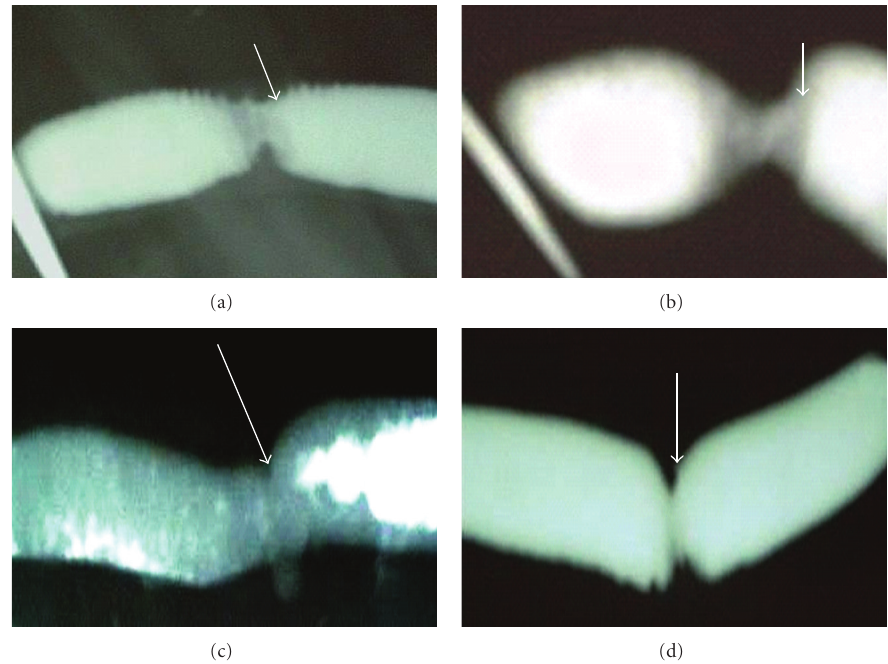
Figure 1: X-ray photographs of experimental intestinal anastomosis in goat showing di ff erent stenosis degrees (arrows). (a) Sero- submoucosal interrupted suturing (SSIS) group on 4th postoperative day (POD). (b) HMIS group on 4th POD. (c) SSIS group on 21st POD. (d) HMIS group on 21st POD.